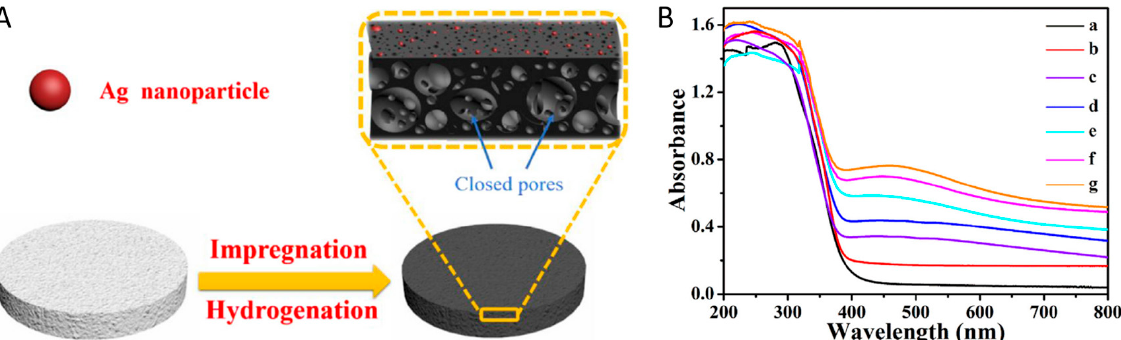
Figure 11. ( A ) Schematic view for the synthetic process of Ag/black TiO 2 foams; ( B ) The UV-vis absorption spectra of black TiO 2 foams (a) and Ag-black TiO 2 foams with different Ag contents of 0.5 (b), 1 (c), 2 (d), 3 (e), 4 (f), and 5 wt.% (g). Reprinted with permission for ref. [105]. Copyright 2018, Elsevier.